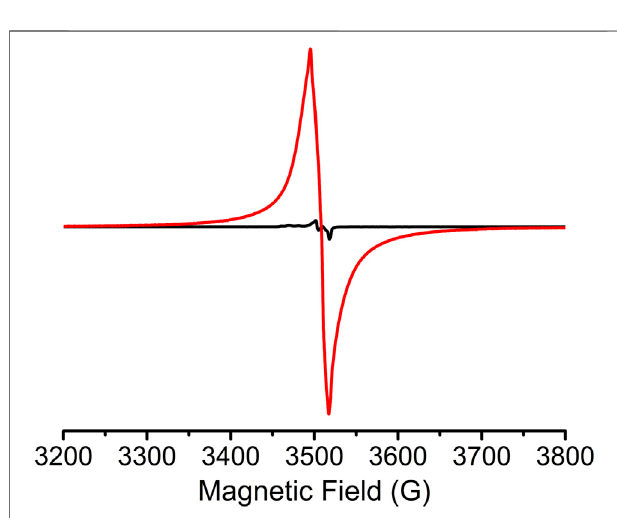
FIGURE 6 | Solid-state EPR spectra of pristine (black) and I 2 -treated (red) sine -MOF.